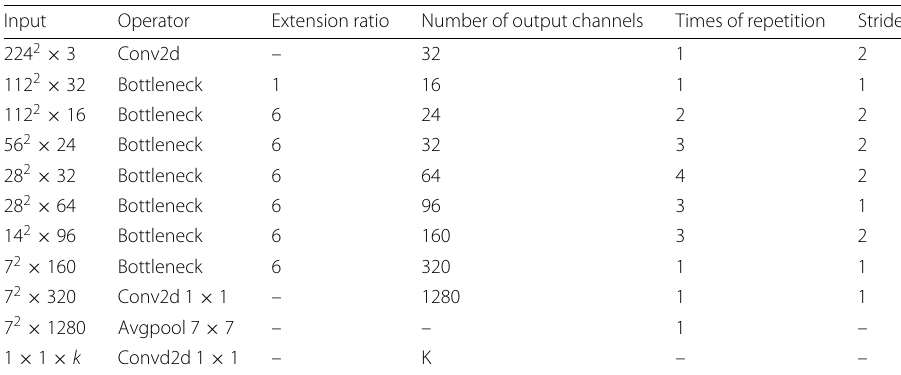
Table 1 MobilenetV2 structural